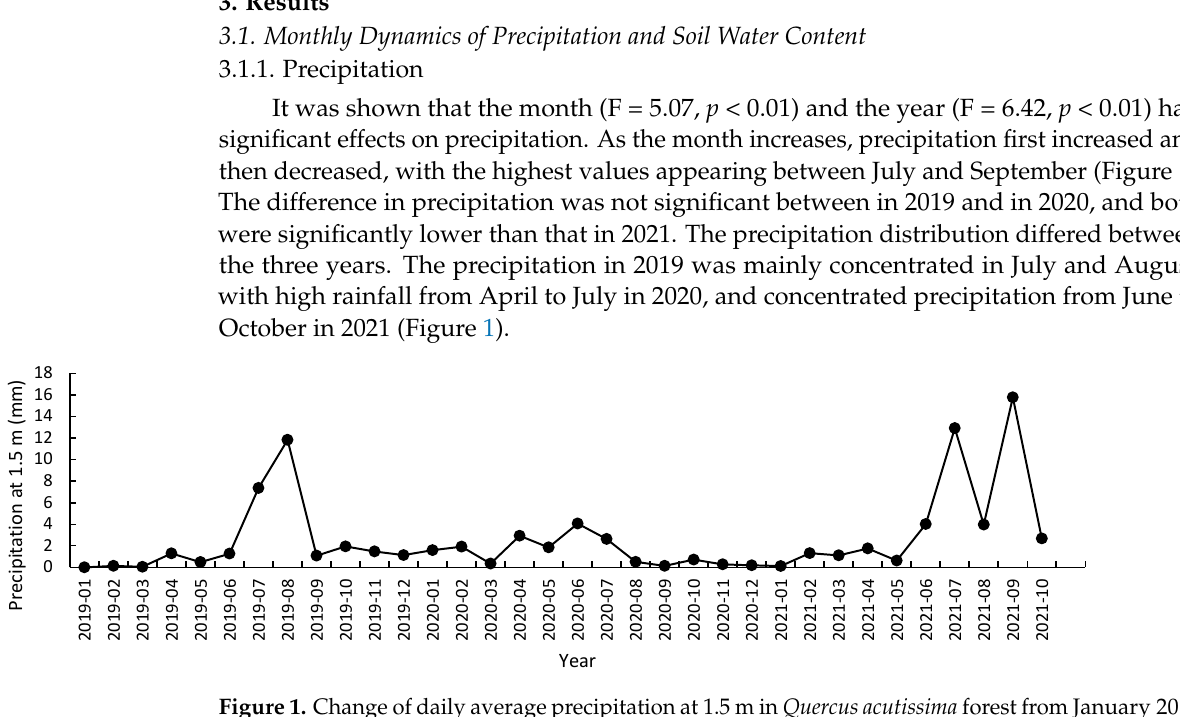
Figure 1. Change of daily average precipitation at 1.5 m in Quercus acutissima forest from January 2019 to October 2021.